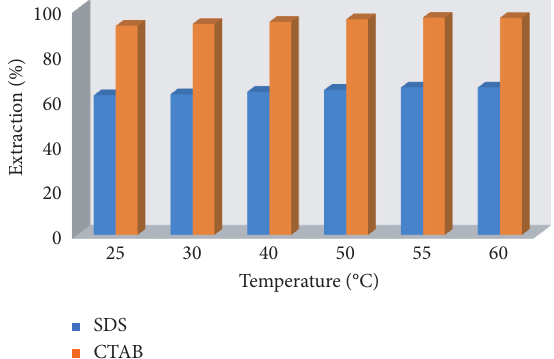
Figure 11: Effects of the temperature on extraction% of RY145 at concentration 6 × 10 − 5 mol/10 ml (contact time: 50min), surfactant concentration 9 × 10 − 2 mol/10 ml, and solution pH 7.2 for CTAB and pH 4.2 for SDS.